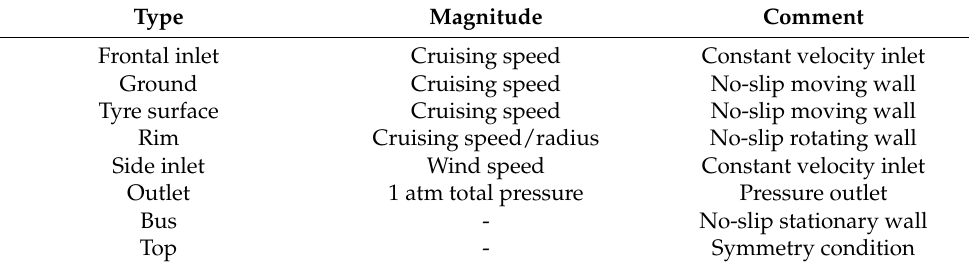
Table 2. Boundary conditions.